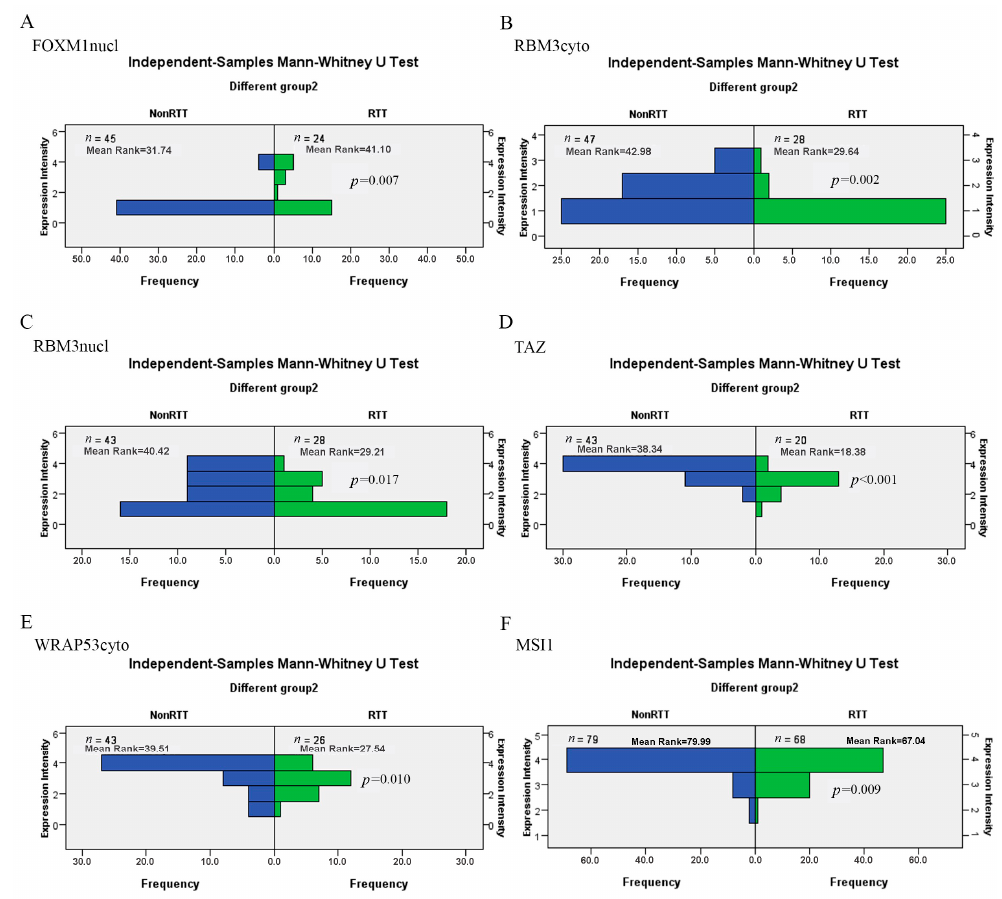
Figure 1. The expression of six markers in primary tumor tissue was affected by RT ( p < 0.05). ( A ) FOXM1nucl (increased, p = 0.007); ( B ) RBM3cyto (reduced, p = 0.002); ( C ) RBM3nucl (reduced, p = 0.017); ( D ) TAZ (reduced, p < 0.001); ( E ) WRAP53cyto (reduced, p = 0.010); and ( F ) MSI1